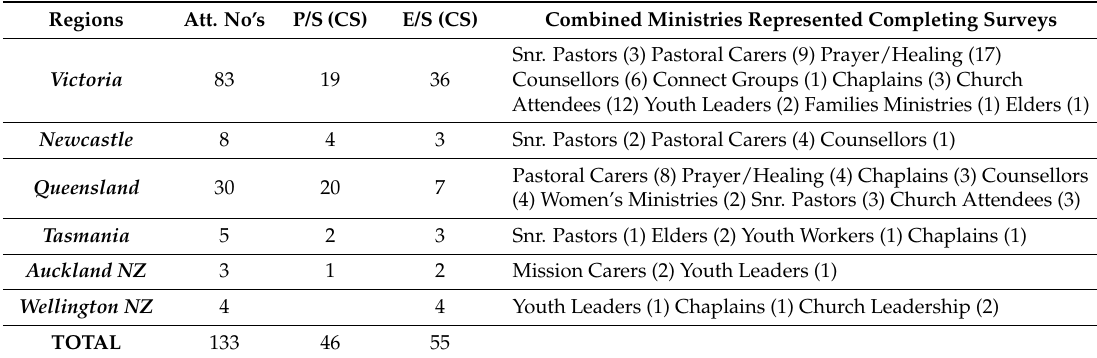
Table 1. Evangelical & Pentecostal ministries represented.